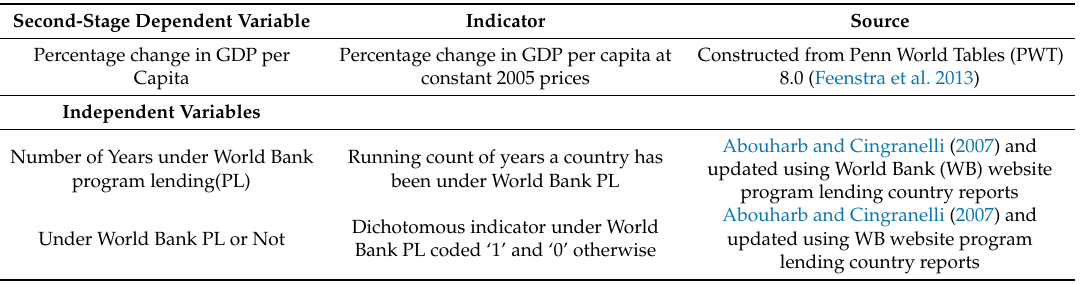
Table 1. Operationalization of